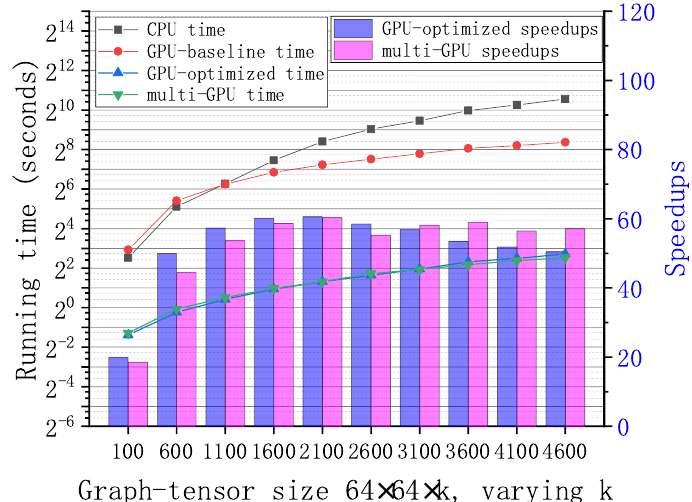
Figure 6. Running time of the GPU-base baseline, optimized, and multi-GPU implementations and the CPU MATLAB implementation with synthetic graph-tensors of 64 × 64 × k . Speedups of the GPU-optimized and multi-GPU implementations correspondingly.